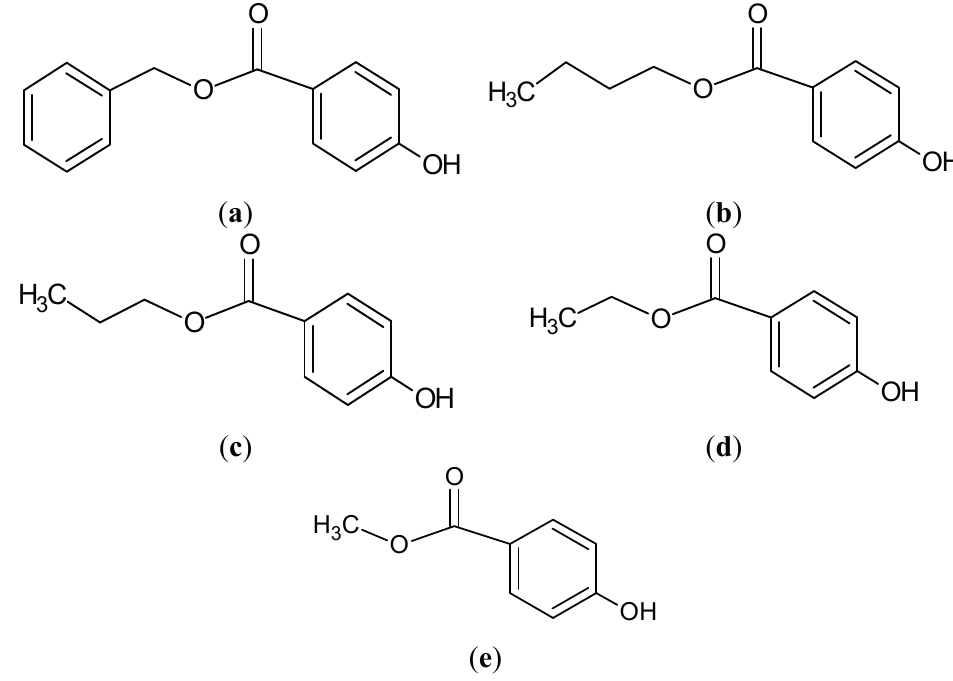
Figure 3. Types of parabens: ( a ) BzP; ( b ) BuP; ( c ) PrP; ( d ) EtP; and ( e )